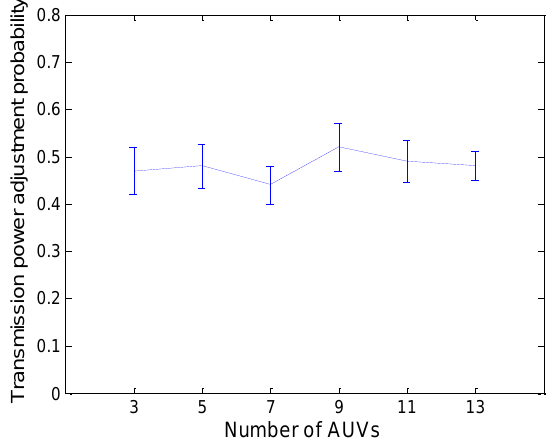
Figure 11. The average transmission power adjustment probability of PTC-FTC.